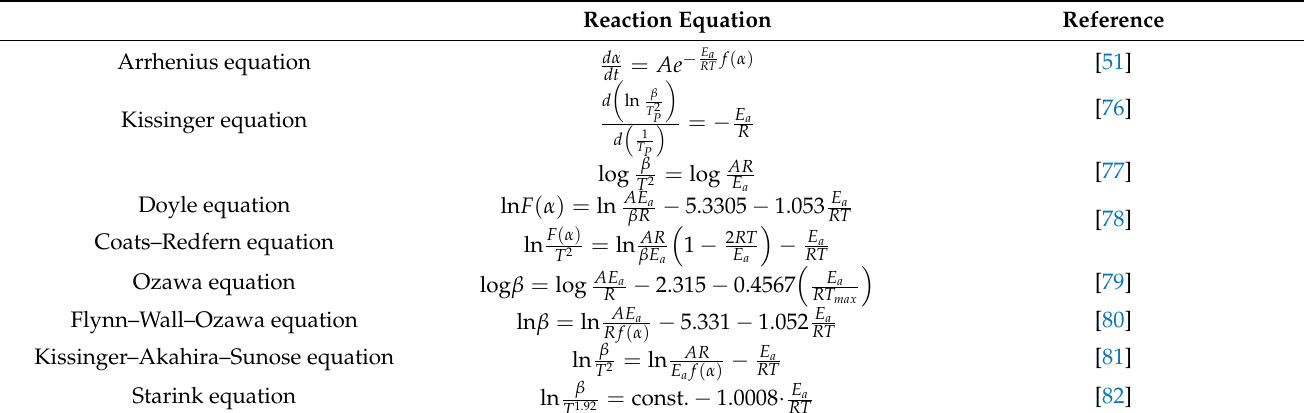
Table 4. Reaction kinetic equation of solid–gas